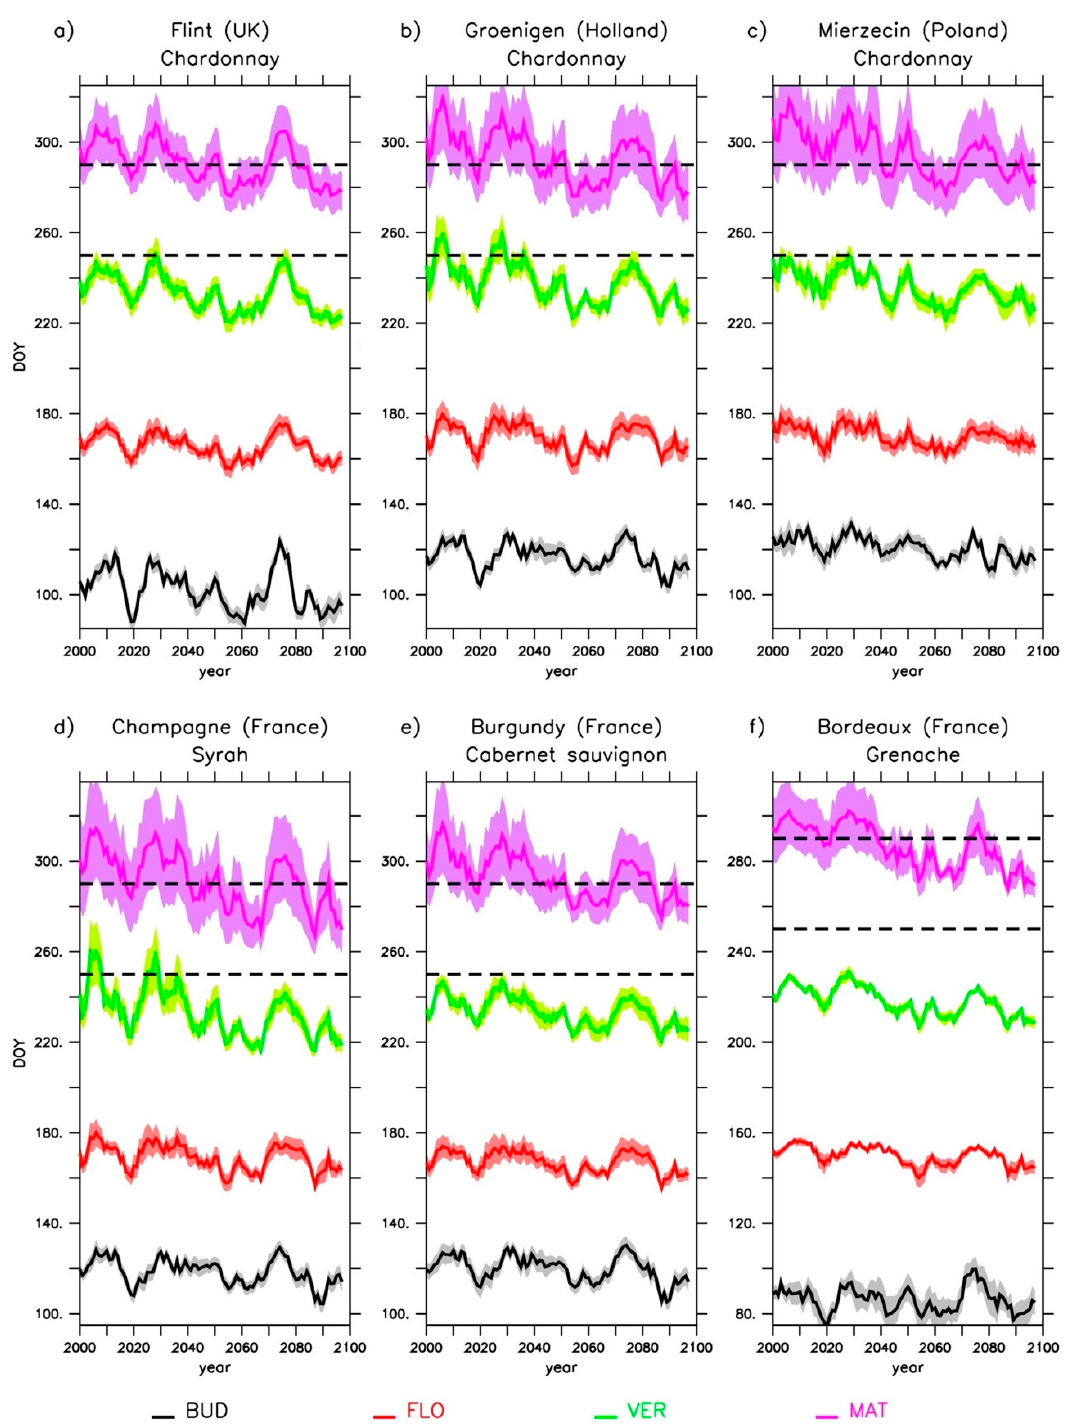
Figure 6. As Figure 5 but for different varieties and locations: ( a ) Chardonnay in UK, ( b ) Chardonnay in Holland, ( c ) Chardonnay in Poland, ( d ) Syrah in Champagne, ( e ) Cabernet Sauvignon in Burgundy, and ( f ) Grenache in Bordeaux.